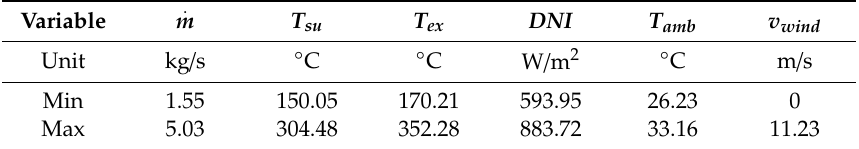
Table 1. Range of the operation of the EuroTrough collectors (ETC) main variable and of the external ambient condition during the experimental campaign.